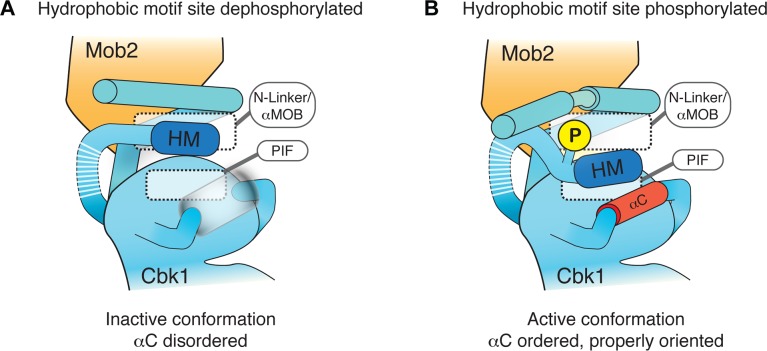
Model for role of Mob binding and HM phosphorylation in NDR/LATS kinase activation.Mob supports the NDR/LATS kinase N-terminal extension in a conformation that creates a binding slot for both HM-T and HM-P. (A) HM-T remains associated with the N-linker region in a manner that does not promote an ordered conformation of the αC helix. (B) HM-P promotes reorganization of αMob, compressing the HM binding slot and holding aromatic side chains of the HM in a configuration that favors ordering of αC.